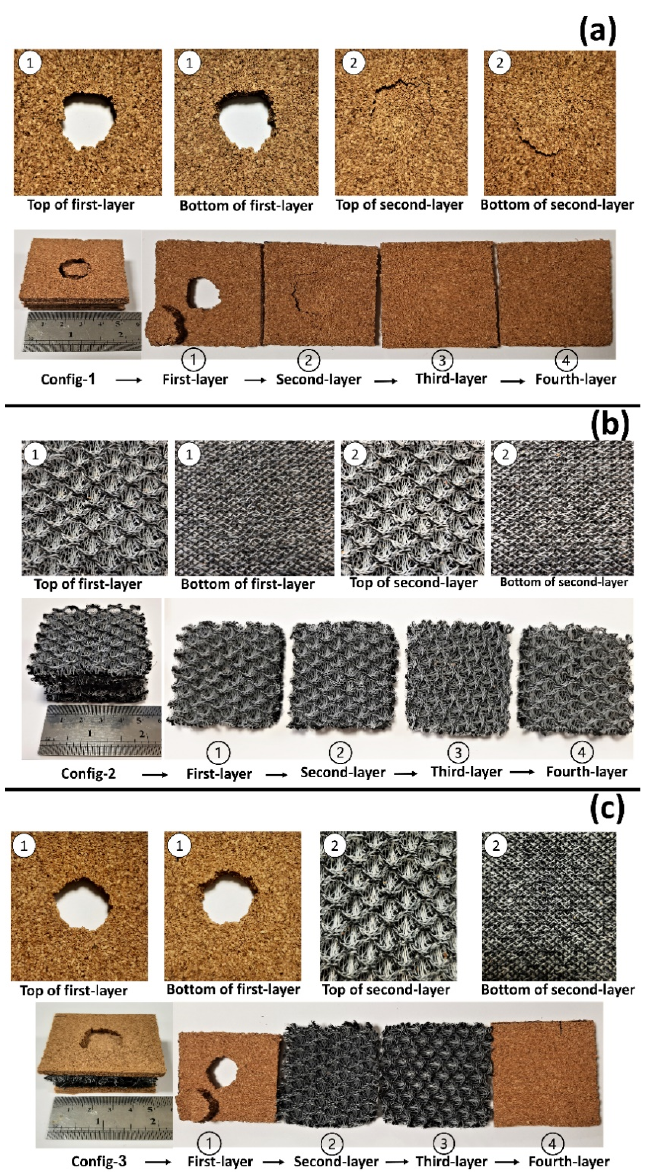
Figure 6. Deformation of configurations of ( a ) Config-1, ( b ) Config-2 and ( c ) Config-3 after drop tests from 1.00 m.